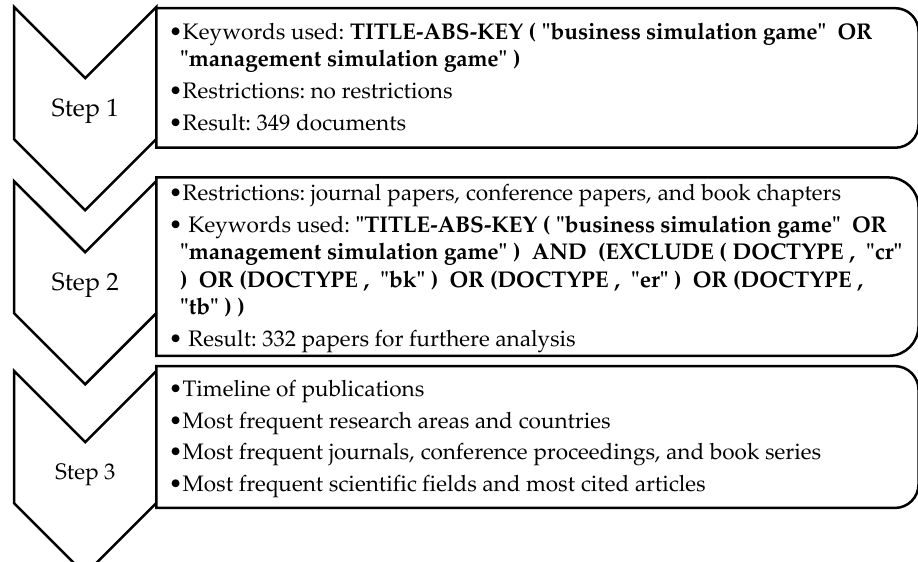
Figure 2. Stages of SLR; Source: Authors’ work.